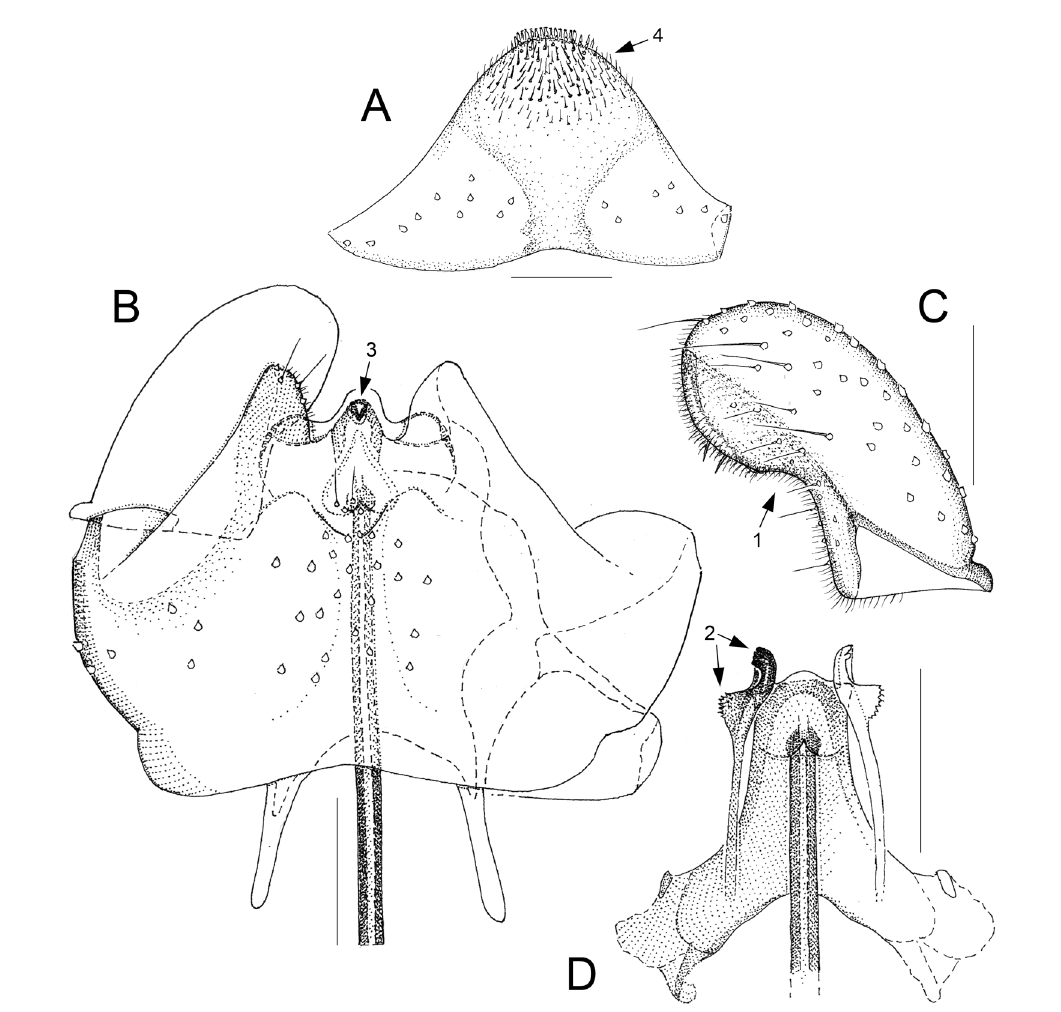
Fig. 10. Glemparon orautahi sp. nov., holotype, ♂ (NZAC, no. CEC1428). A . Ninth tergite, dorsal. B . Genitalia, ventral. C . Gonostylus, ventral. D . Apex of ejaculatory apodeme and tegmen, ventral. Scale bars = 0.05 mm. Numbered arrows indicate diagnostic characters (see Diagnosis and other